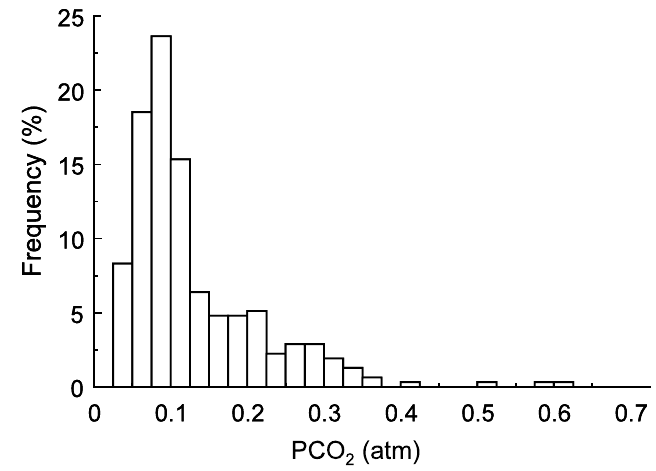
Figure 9. Histogram showing the distribution frequency (%) of the P values from Saibbo well. The plot shows unimodal distribution of the P values centered around 0.1 atm, with residual ‘tail’ values up to 0.6